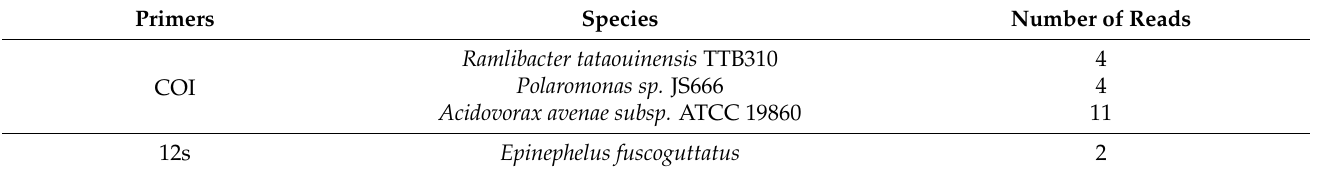
Table 3. Sequencing results of COI, 12s, 16s primer from testing